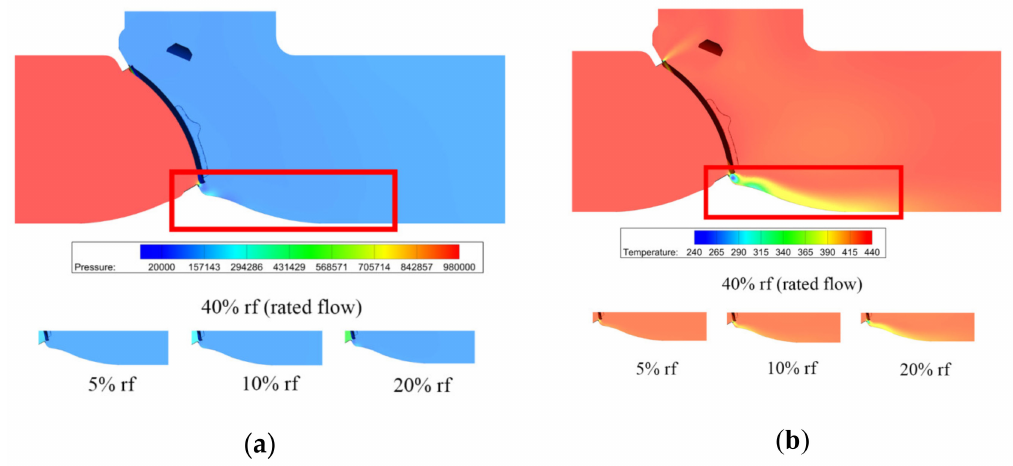
Figure 10. Pressure and temperature distributions under di ff erent mass flow rates: ( a ) pressure distribution; ( b ) temperature